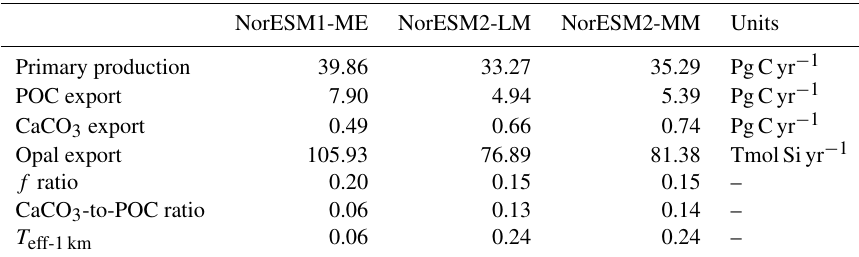
Figure 5. Climatological seasonal mixed layer depth as (left column) simulated in NorESM2-MM and (right column) estimated from obser- vations. Table 3. Annual mean biology-related metrics simulated by NorESM1-ME, NorESM2-LM, and